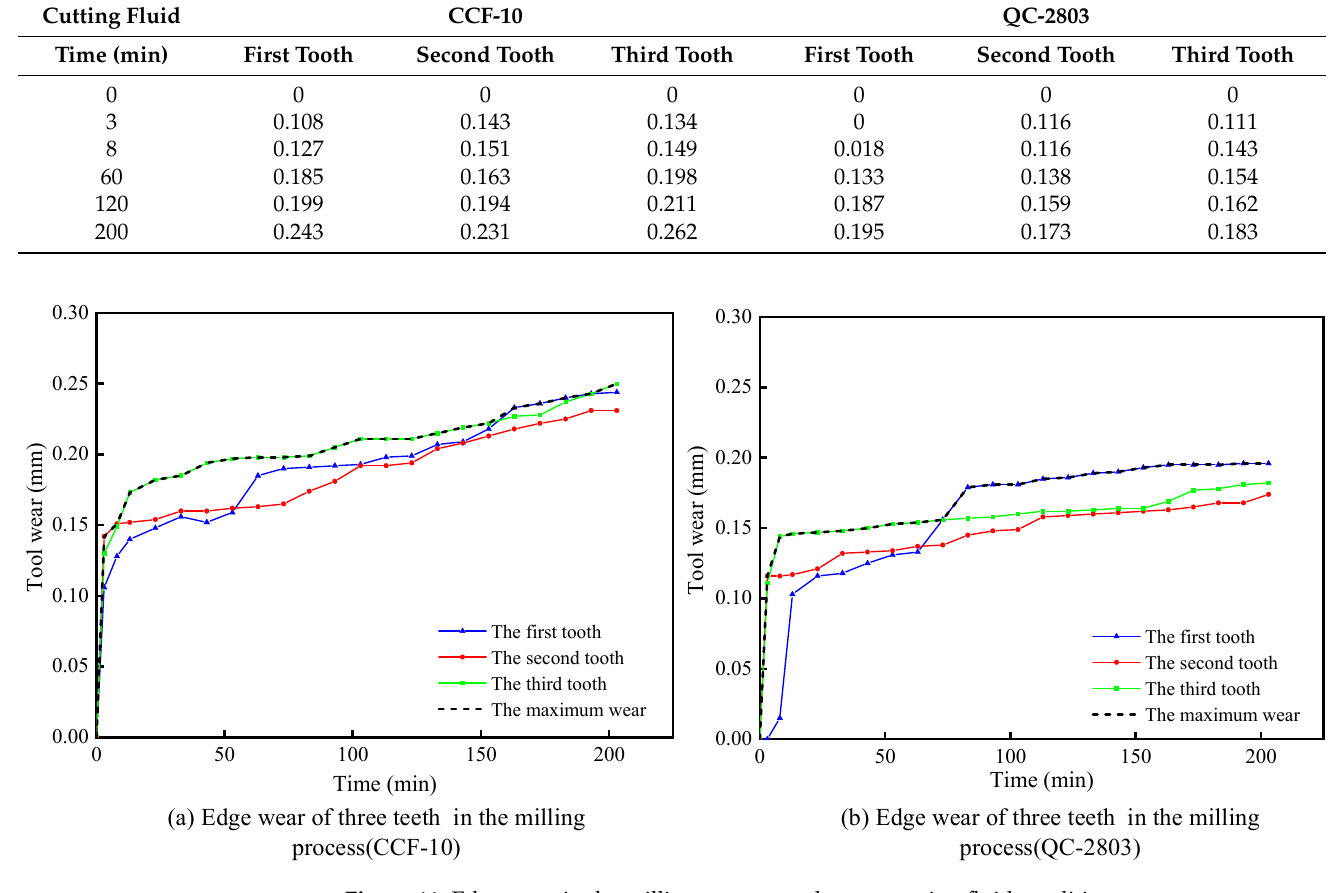
Figure 11. Edge wear in the milling process under two cutting fluid conditions.